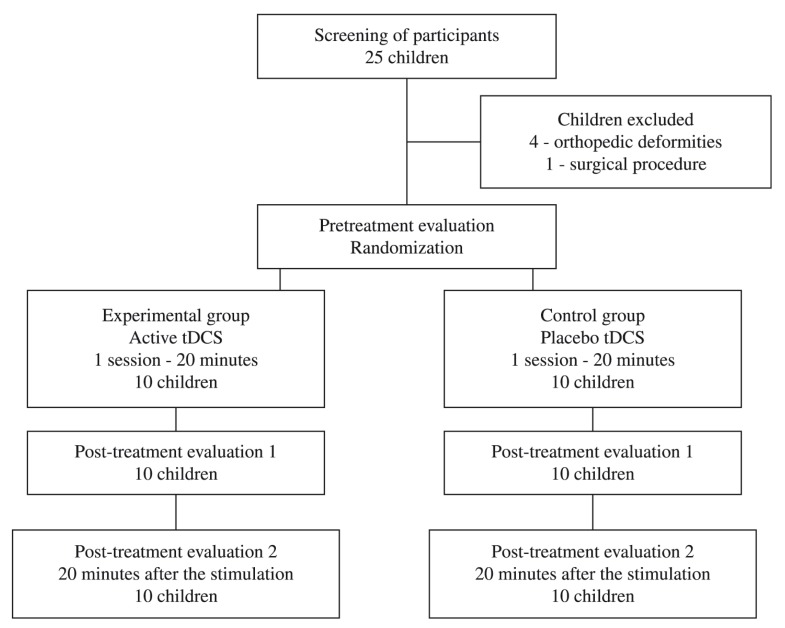
Flow diagram of study based on the Consolidated Standards of Reporting
Trials (CONSORT) Statement.